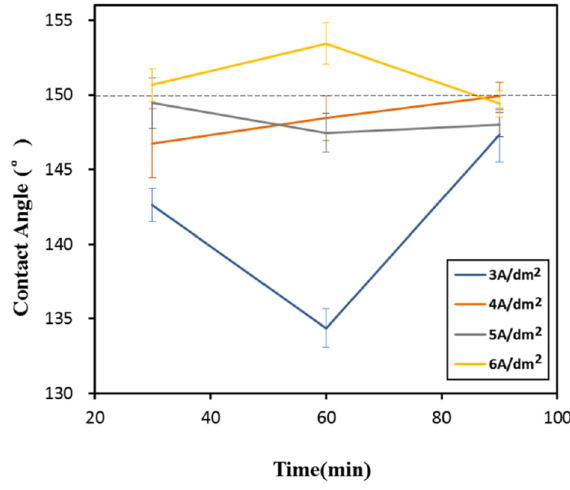
Figure 5. Plating time versus contact angle for the prepared samples.